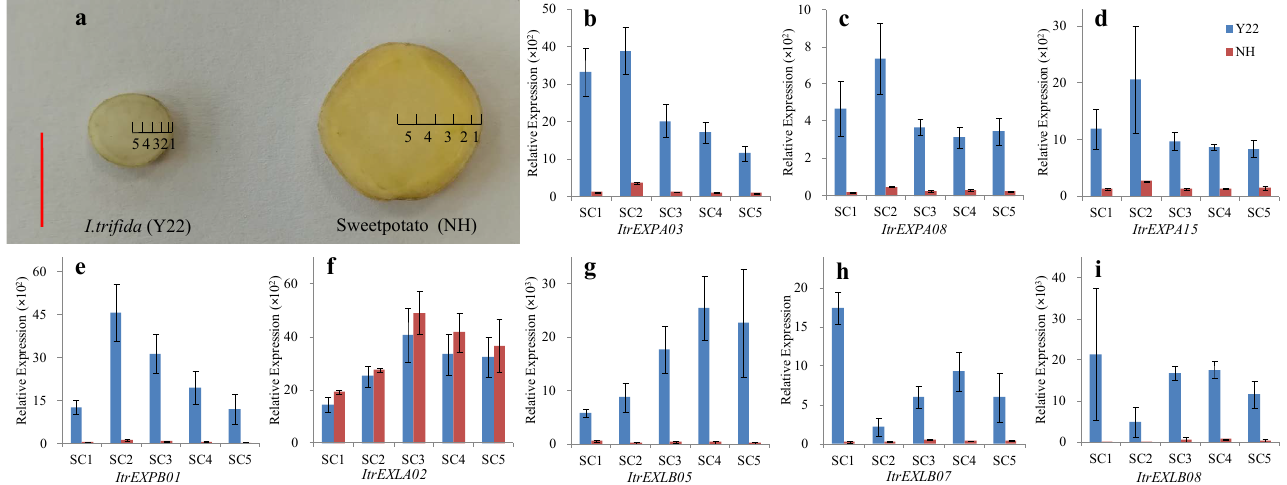
Figure 7. The expression of eight ItrEXPs in SR. ( a ) The YSRs of I. trifida (Y22) and sweetpotato cv. Nancy Hall (NH). Red bar, 1 cm. The number represents the SC1, SC2, SC3, SC4 and SC5, respectively. SC1: the outer section of the cortex; SC2: the inner part of the cortex and outermost part of the stele; SC3: the outer part of the stele; SC4: the middle part of the stele; SC5: the inner part of the